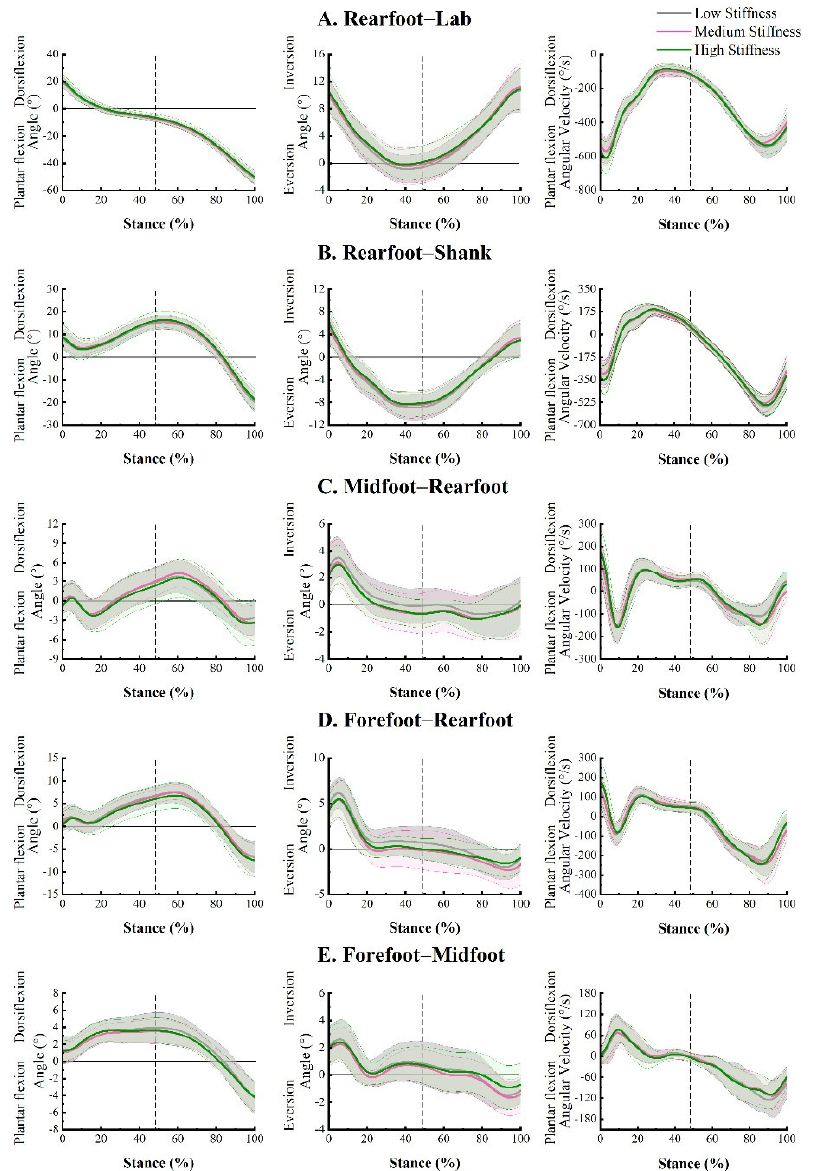
Figure 4. Averaged angle-time curves displayed in the sagittal and frontal planes (first and second columns, respectively) and angular velocity-time curves in the sagittal plane (third column) for rearfoot-lab ( A ), rearfoot-shank ( B ), midfoot-rearfoot ( C ), forefoot-rearfoot ( D ), and forefoot-midfoot ( E ) movements during running stance phase while wearing three shoe conditions. Grey, pink, and green curves separately indicate the low stiffness, medium stiffness, and high stiffness conditions. The dashed line reflects the anterior-posterior force crossed